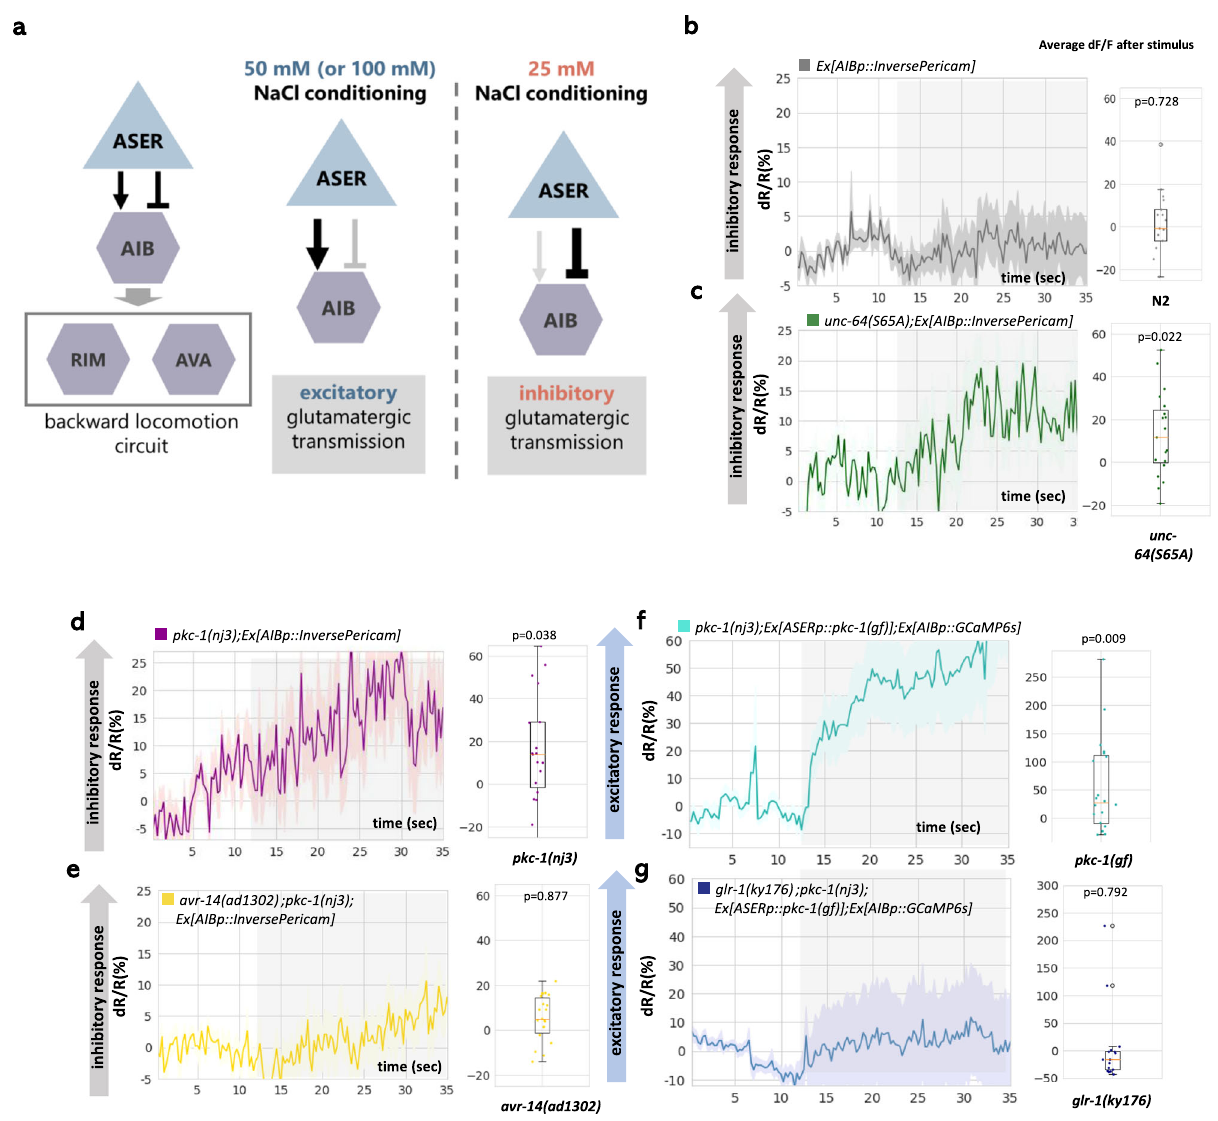
Fig. 5 Response of AIB interneuron to NaCl concentration change is reversed by PKC-1 and UNC-64 Ser65. a Summary of the study by Sato et al., 2021. AIB responds to a change in NaCl concentration via glutamatergic input from ASER. Furthermore, the synaptic transmission between ASER and AIB can be excitatory or inhibitory, according to the NaCl concentration experienced in the conditioning phase. b – d The response of AIB to NaCl concentration change from 50 to 25 mM measured in freely moving animals by the same setting as Sato et al., 2021 (see “ Methods ” ). Inverse-Pericam, an inverse-type fl uorescent calcium probe was used for imaging. An inhibitory response was observed in pkc-1(nj3lf) and unc-64(S65A) mutants. e The inhibitory response caused by pkc-1(nj3lf) was diminished in the mutant of inhibitory glutamate receptor, avr-14 (ad1302) . f AIB exhibited an excitatory response in pkc- 1(nj3);Ex[ASERp::pkc-1(gf)] . The calcium probe GCaMP6s was used for the imaging. g The excitatory response caused by ASERp:: pkc-1(gf) was diminished in the mutant of the excitatory glutamate receptor, glr-1(ky176) . In b – g , the vertical gray shading indicates a decrease in NaCl concentration (50 – 25 mM) in solution surrounding the animals in the micro fl uidic device. The lines with the shade(error band) show the average and SEM, respectively, of changes in GCaMP or Inverse-Pericam fl uorescence. In the right panels, the boxes extends from 25th to 75th percentile, median is marked by the line, and whiskers indicate the minimum and the maximum values in 1.5× the inter-quartile range. p values were calculated by one-sample Welch ’ s test(two-sided). n = 17 (N2), 19 ( unc-64(S65A) ), 19 ( pkc-1(nj3) ), 22 ( avr-14(ad1302); pkc-1(nj3) ), 20 (ASERp:: pkc-1(gf) ), and 16 (ASERp:: pkc-1(gf) ; glr-1(ky176) ), independent animals, respectively. Source data are provided as a Source Data fi